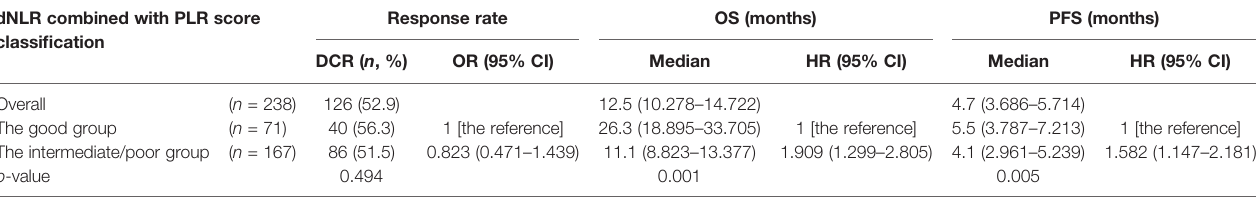
TABLE 4 | Ef fi cacy and prognosis based on the good and the intermediate/poor groups. dNLR combined with PLR score classi fi cation